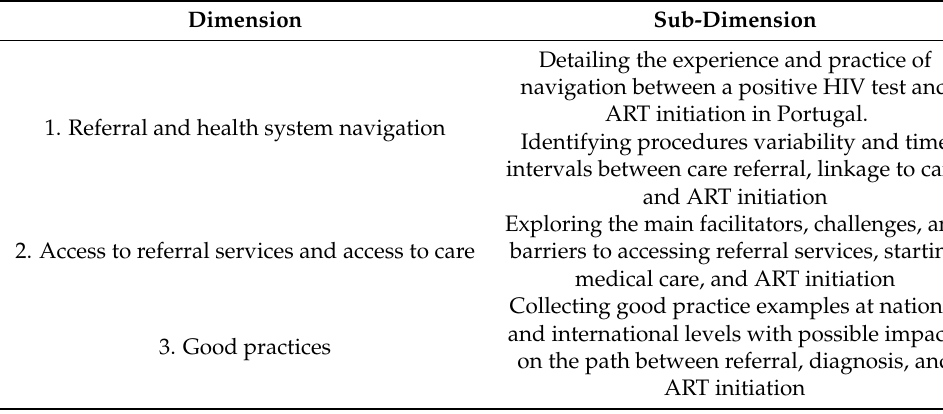
Table 1. Topics of the interview